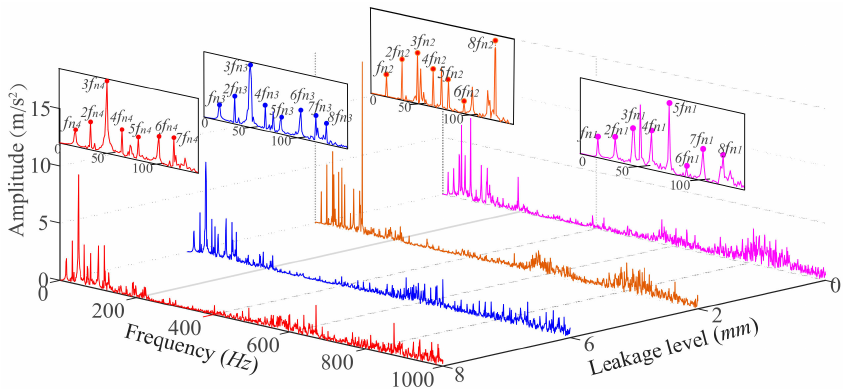
Figure 11. Frequency-domain waveform of response